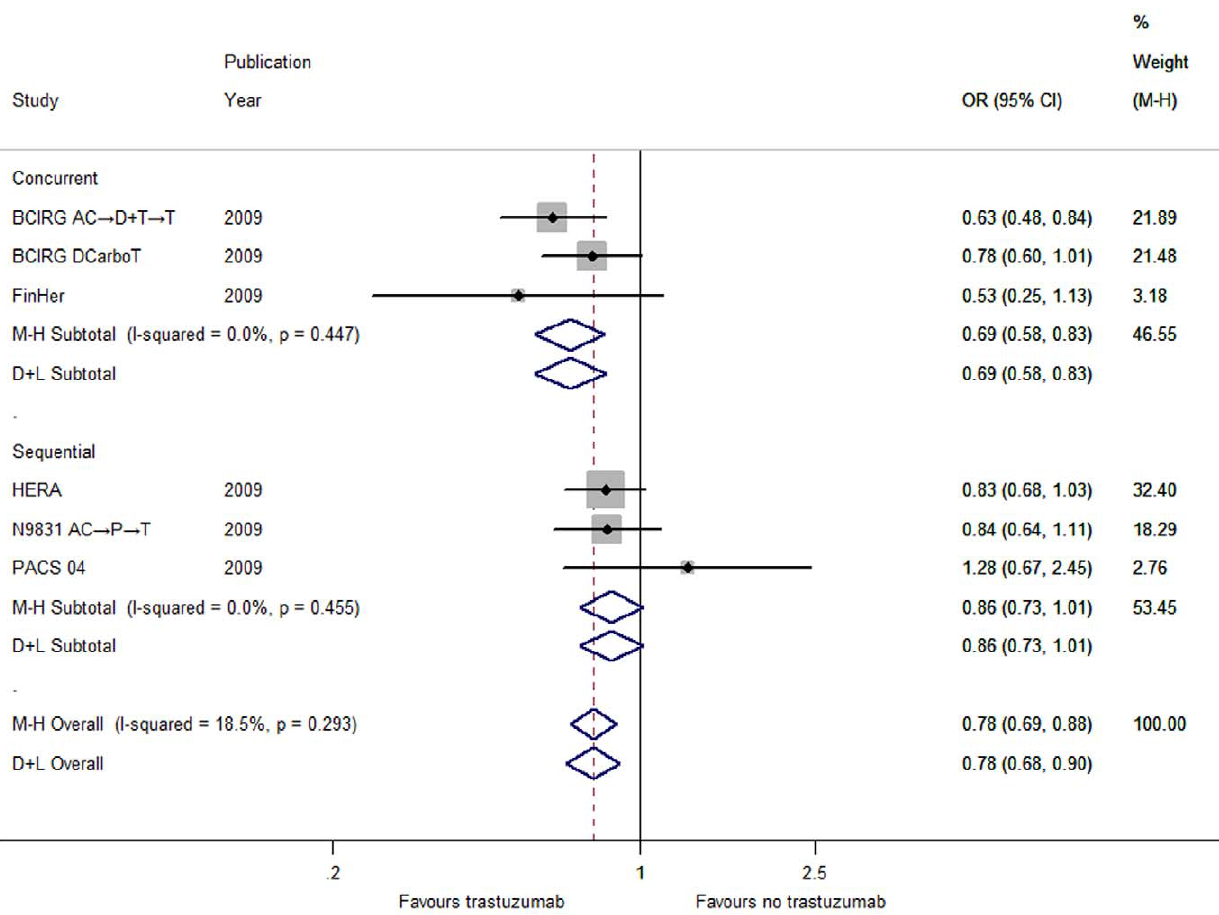
Figure 1. Forest plots of OR for the association between trastuzumab administration and overall survival by the timing of trastuzumab initiation with respect to chemotherapy (including the DCarboT arm of the BCIRG 006 trial). The size of the square box is proportional to the weight that each study contributes in the meta-analysis. The overall estimate and confidence interval are marked by a diamond. Symbols on the right of the solid line indicate OR . 1 and symbols on the left of the solid line indicate OR , 1. Abbreviations: M-H=Mantel-Haenszel (fixed-effects method); D + L=DerSimonian and Laird (random-effects method).